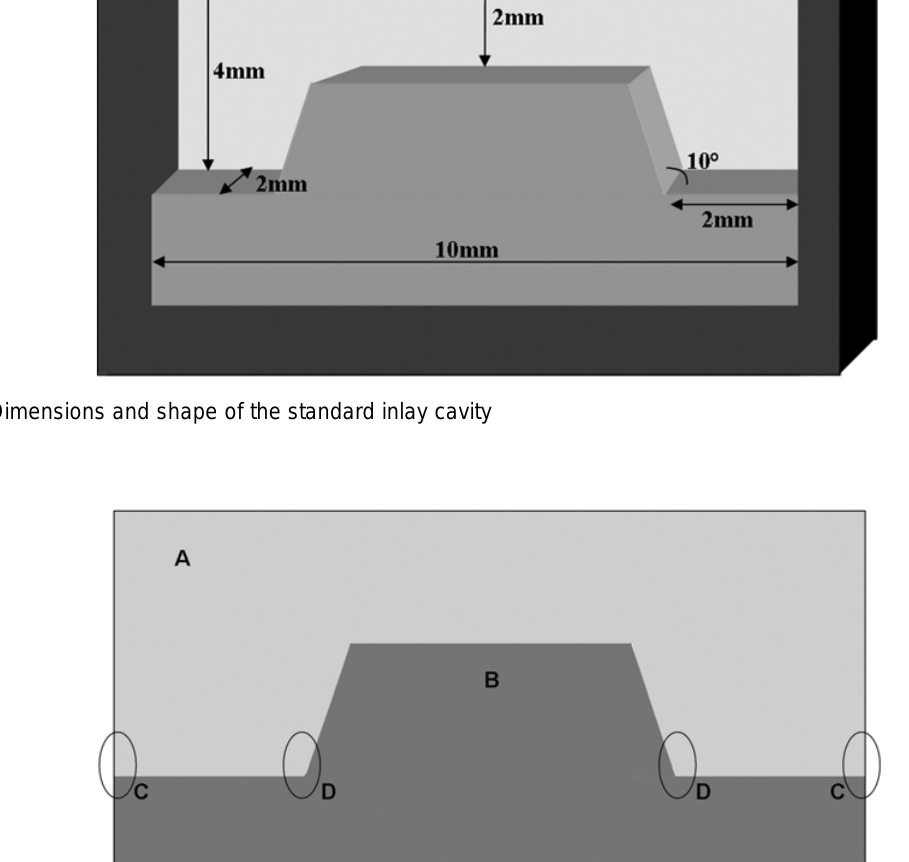
FIGURE 3- Gap measurement points: (A) composite resin; (B) brass mold; (C) cervical margin (mesial and distal); (D) internal angles (cervical-axial, mesial and distal)